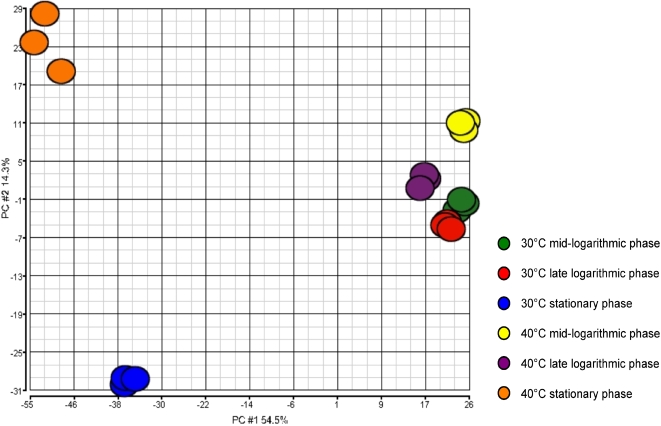
Principal component analysis (PCA) plot expression of microarray data.The figure shows transcriptome differences between strain NEM316 incubated in THY at 30°C and 40°C. The PCA plot captures the variance in a dataset in terms of principal components and displays the most significant of these on the x and y axes. The percentages of the total variation that are accounted for by the 1st and 2nd principal components are shown on the x- and y-axes labels. The results indicate that the transcriptome data are of high quality, as the triplicate samples cluster together according to both temperature of incubation and growth phase.